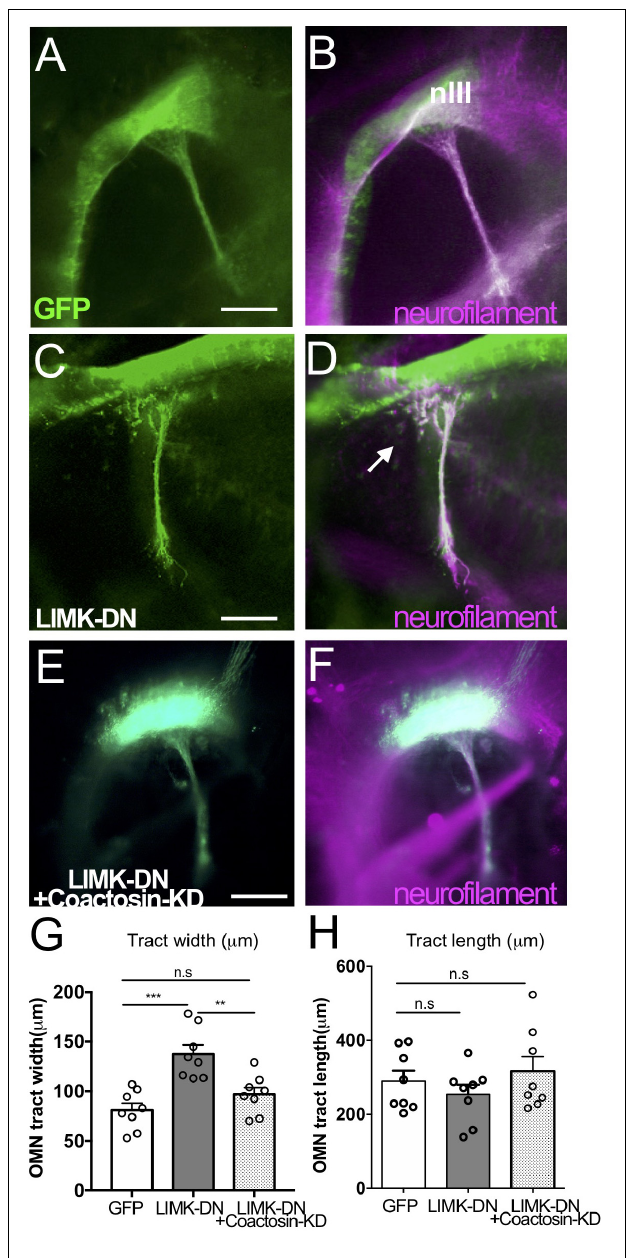
FIGURE 7 | Coactosin function during axon growth under LIMK signals. (A–F) Effects of coactosin on the oculomotor nerve of chick embryos. Oculomotor nuclei were transfected with GFP ( green ) (A,B) , a dominant-negative form of LIMK1 (LIMK-DN, green ) (C,D) , or LIMK-DN plus coactosin shRNA (coactosin-KD, green ) (E,F) . Double staining of neurofilament ( magenta ) showed an elongation of transfected or untransfected oculomotor nerve. In the control condition, oculomotor axons fasciculate, exit the midbrain, and elongate ventrally. Oculomotor axons defasciculated with LIMK-DN treatment (arrows); however, co-electroporation of LIMK-DN and coactosin shRNA reversed this effect. (G) Width of the oculomotor nerve at the exit point from the midbrain. In the LIMK1 inhibition, the defasciculation expanded the width of the nerve (eight embryos for each, ** p = 0.0024, *** p = 0.0001, one-way ANOVA) (H) Length of oculomotor axons from its nucleus. Note that the effect of coactosin knockdown was rescued by LIMK1 inhibition (eight embryos for each, p > 0.05, one-way ANOVA). nIII, oculomotor nucleus, Scale bar: 100 µ